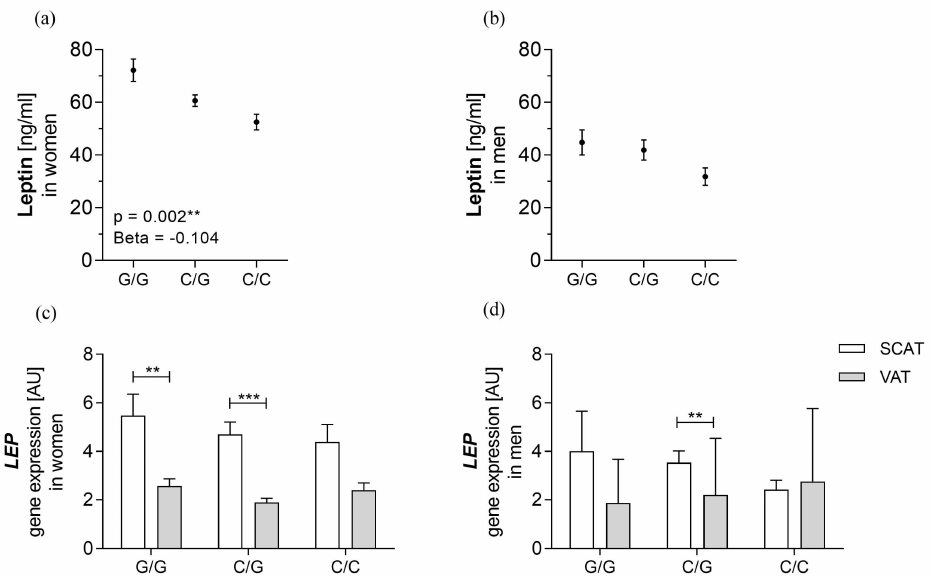
Figure 2. Association of rs10487505 with ( a , b ) circulating leptin and ( c , d ) leptin mRNA in both ATs. Data are shown as mean ± SEM. * p < 0.05; ** p < 0.01; *** p < 0.001 p adjusted for age and BMI.